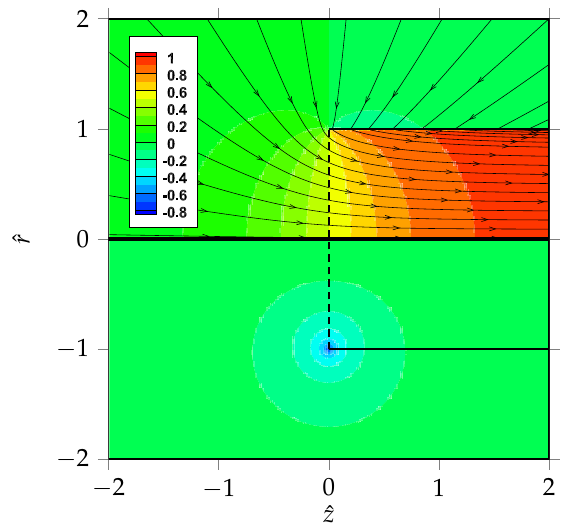
= 0, ˆ R = 1) : streamlines and axial velocity SIVC SIVC